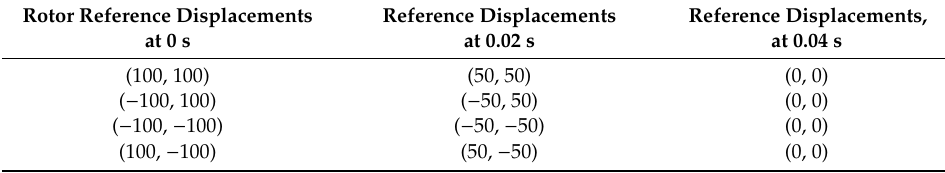
Table 4. Rotor reference displacements with respect to time in all